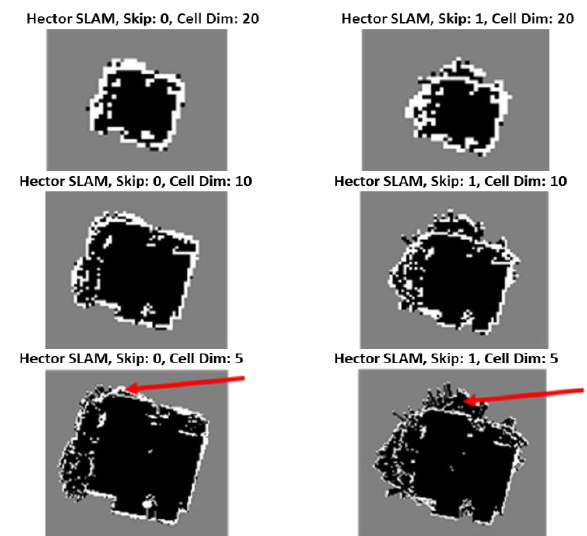
Figure 20. Map Constructed from Hector SLAM During Second Experiment with Different Frames Skipping Steps (No-skipping and One Frame Skipping)